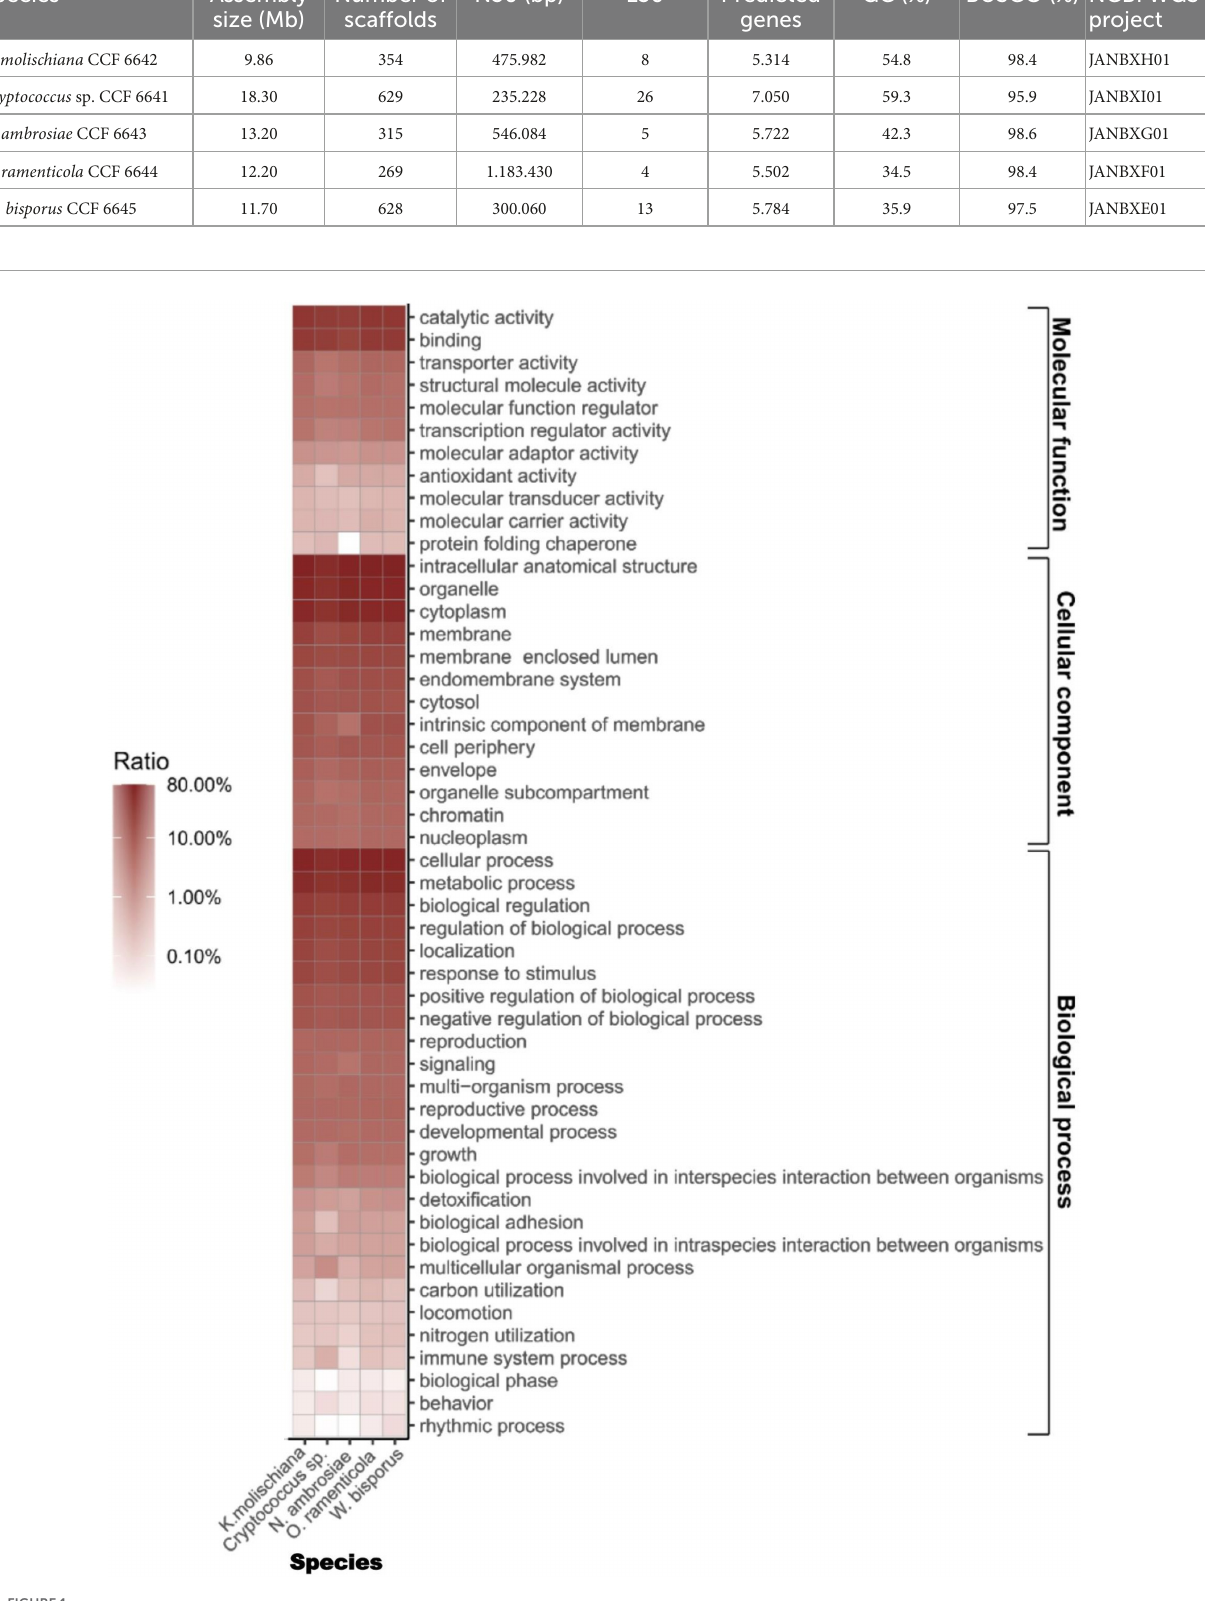
Frontiers in Microbiology